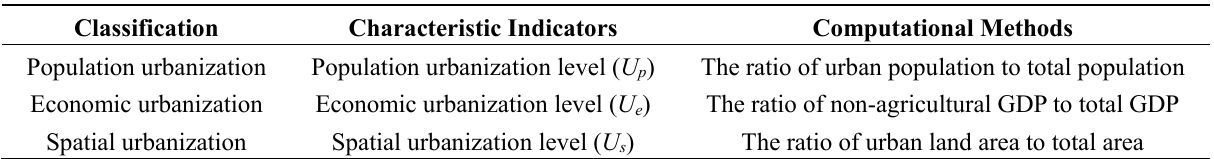
Table 1. Characteristic indicators and the computational methods of